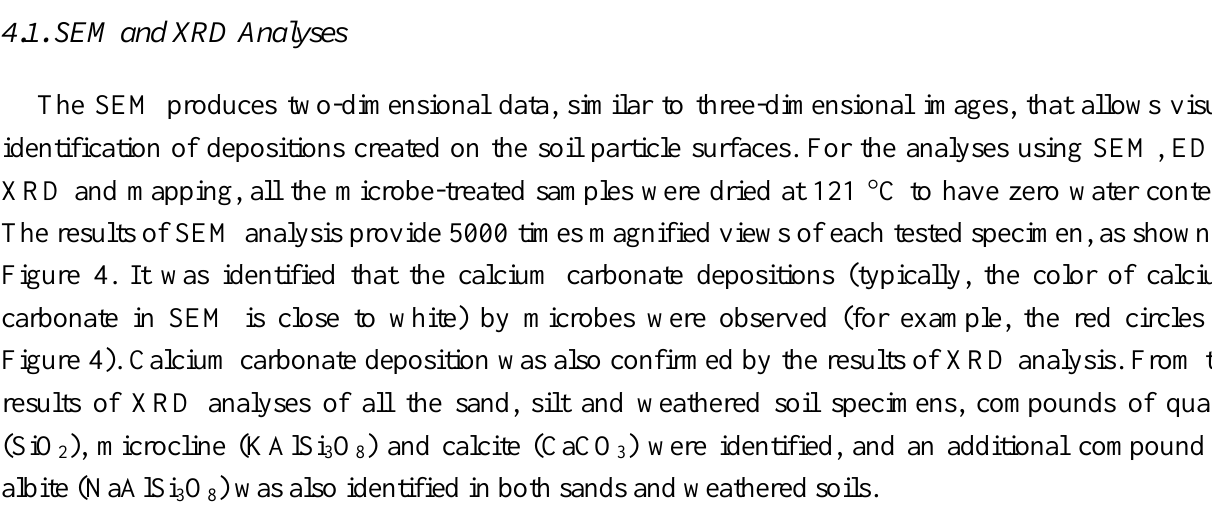
Figure 4. Results of SEM (the magnified image is 5,000 times larger than its original scale) of sand specimens with ( a ) D r = 40%; ( b ) D r = 60% and ( c ) D r = 80%; silt specimens with ( d ) RC = 60%; ( e ) RC = 75% and ( f ) RC = 90%; and ( g ) well-graded, and ( h ) poorly-graded weathered soil